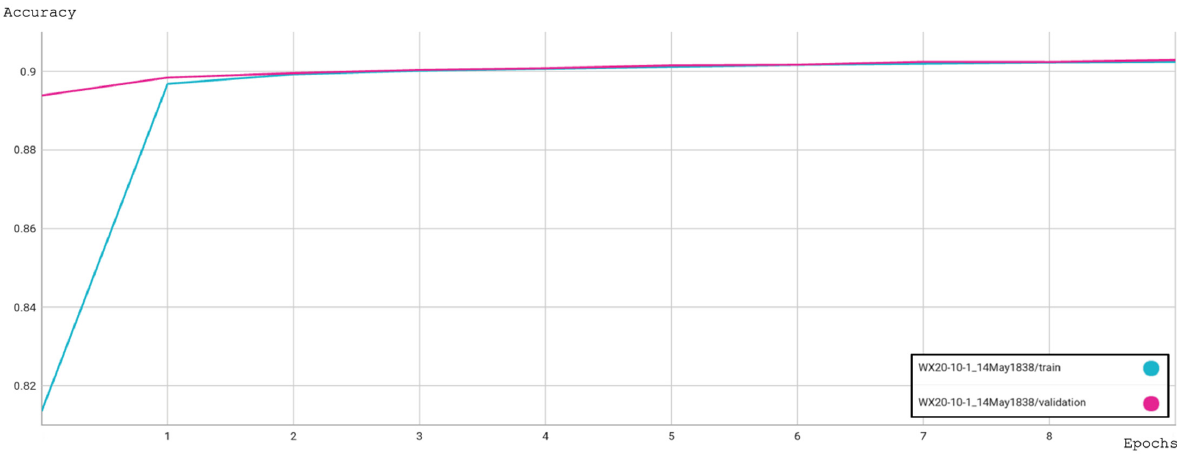
Figure 6. Weather events : model accuracy.